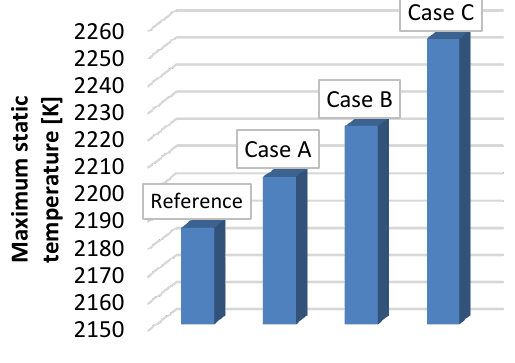
Fig. 9. Maximum static temperature in the combustors